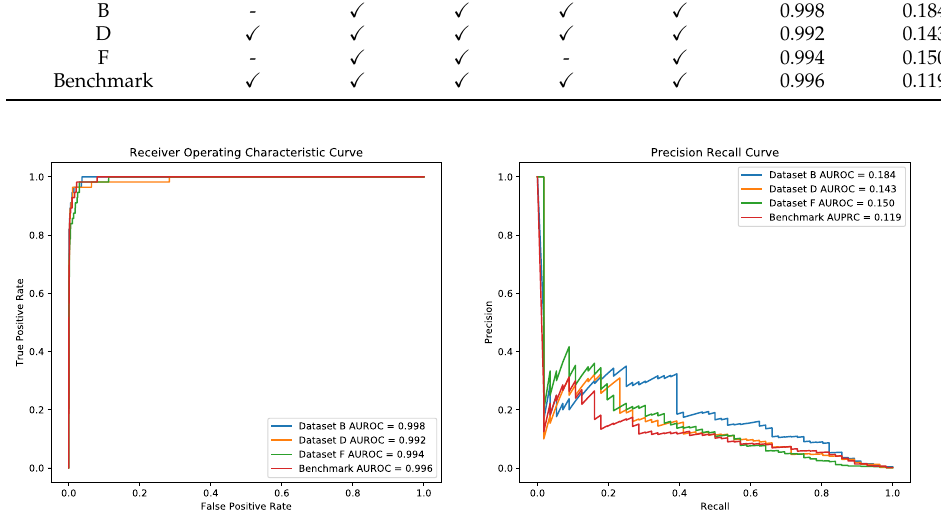
Figure 7. Performance of R-CRISPR with different training datasets on Dataset